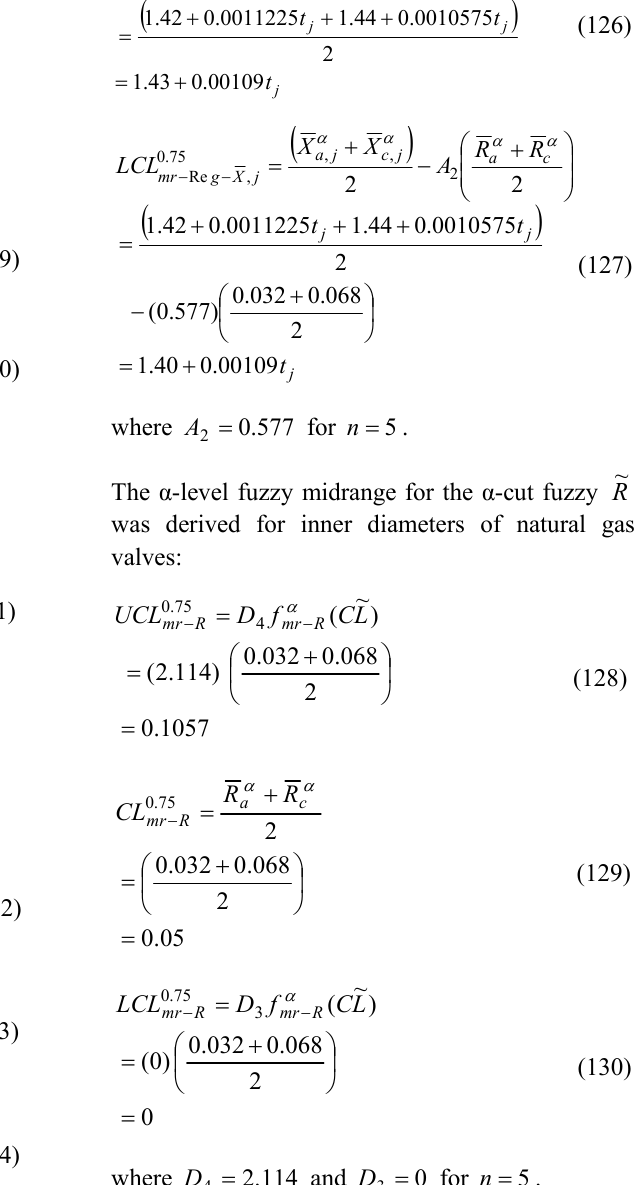
Step 5: The process condition was set to evaluate the process with an α -cut based on the α -level fuzzy midrange transformation technique for the inner diameter of the natural gas valves. and were calculated for 25 samples by using “Eq. (43)”, “Eq.(90)”, respectively, and are given in Table 5.and Table6. As shown in Table 5 the process is “out of control” for only the last sample. Before that, the process was “under control” with respect to When examining the deviation of the process, all samples showed that the process is “under